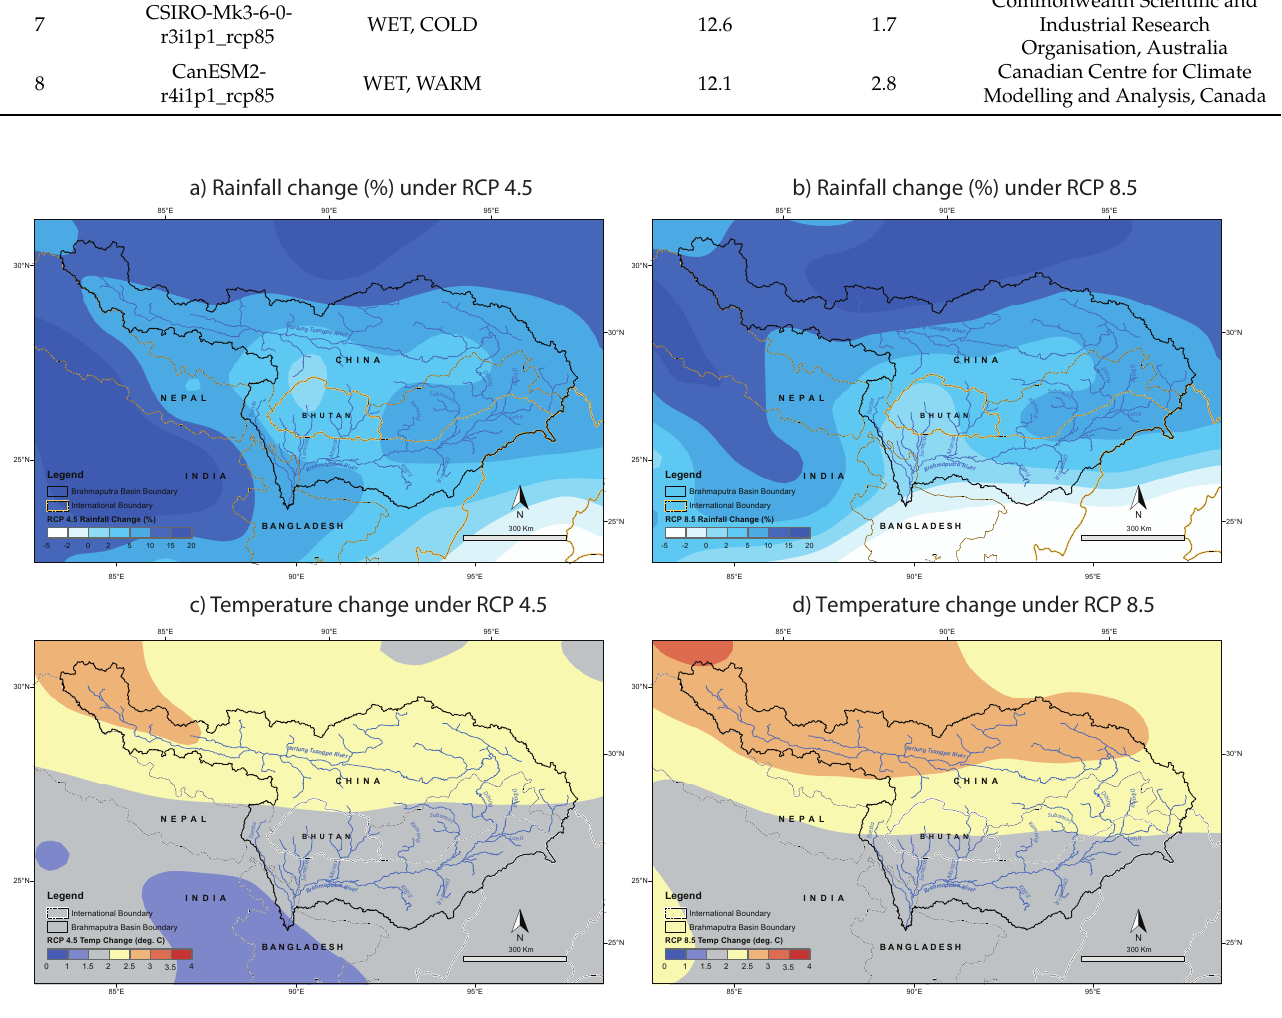
Figure 4. Projected precipitation and temperature change under RCP 4.5 and 8.5 climate change scenarios (mean of the four selected climatic conditions for each scenario) over the Brahmaputra River